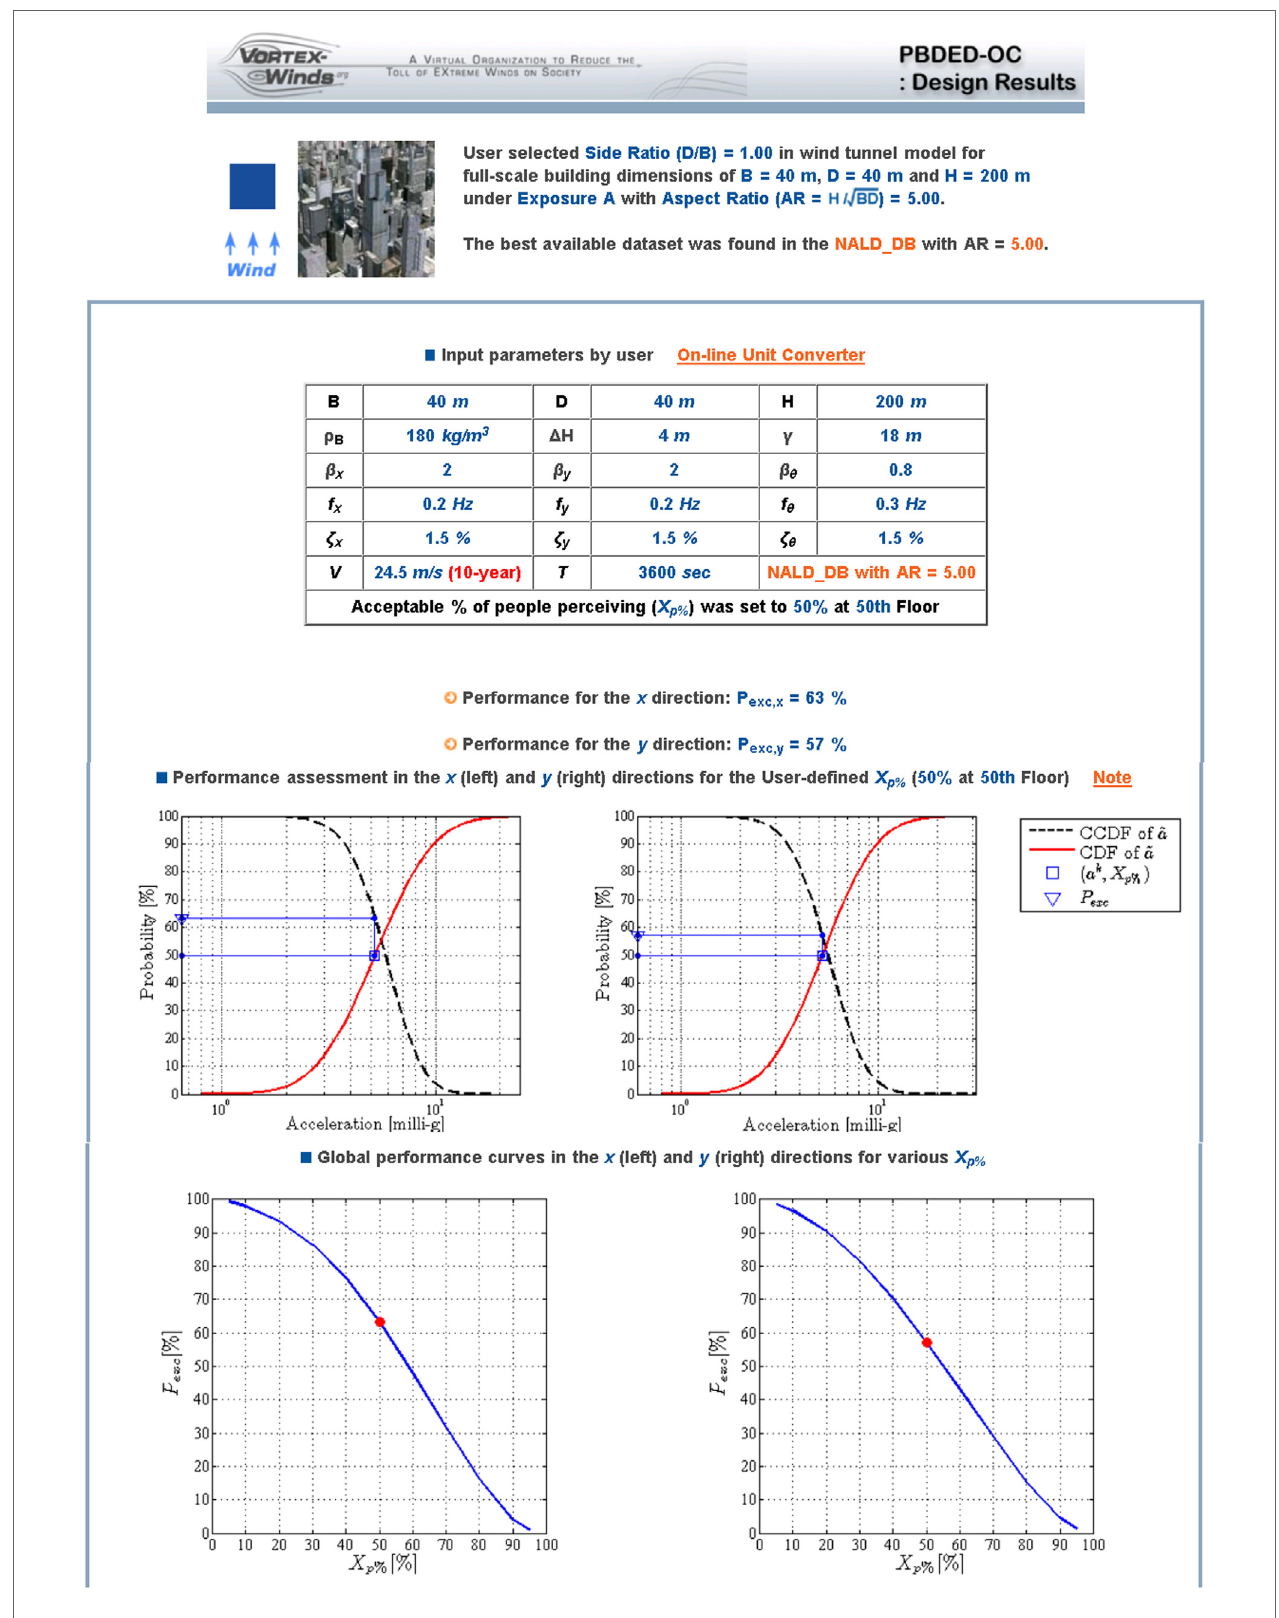
FigUre 7 | Result interface of performance-based design of high-rise buildings for occupant comfort.